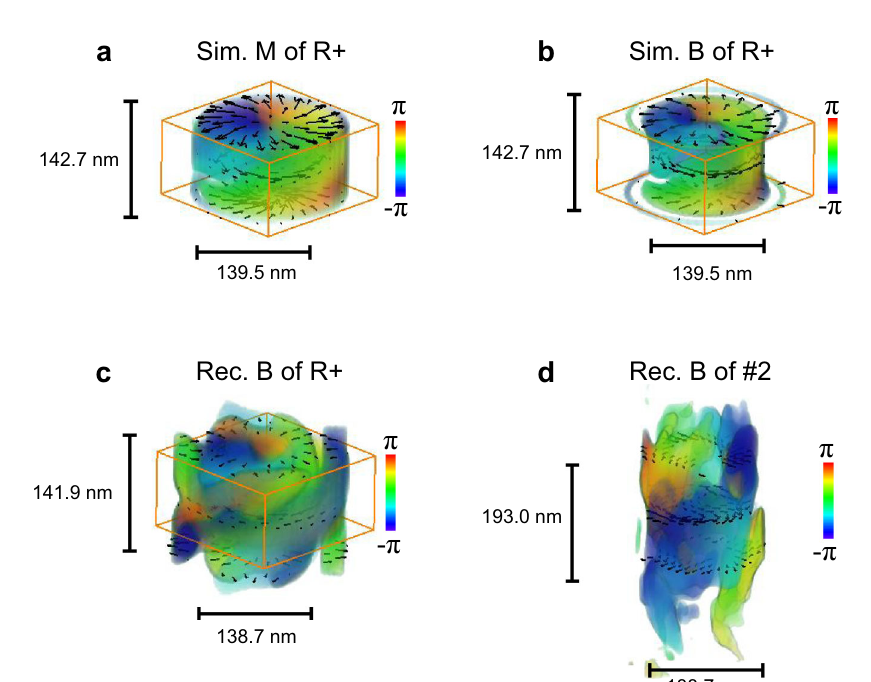
Fig. 3 | The magnetic R+ con fi guration of bubble #2. a Distribution of in-plane magnetizationsinthe3DfeatureoftheR+model. b In-planeinductioncomponents computed with the R+ model. c In-plane induction components reconstructed from tilted LTEM images simulated based on the R+ model. d In-plane induction componentsrecoveredfromtheexperimentaldataofbubble#2.Theboxframesin